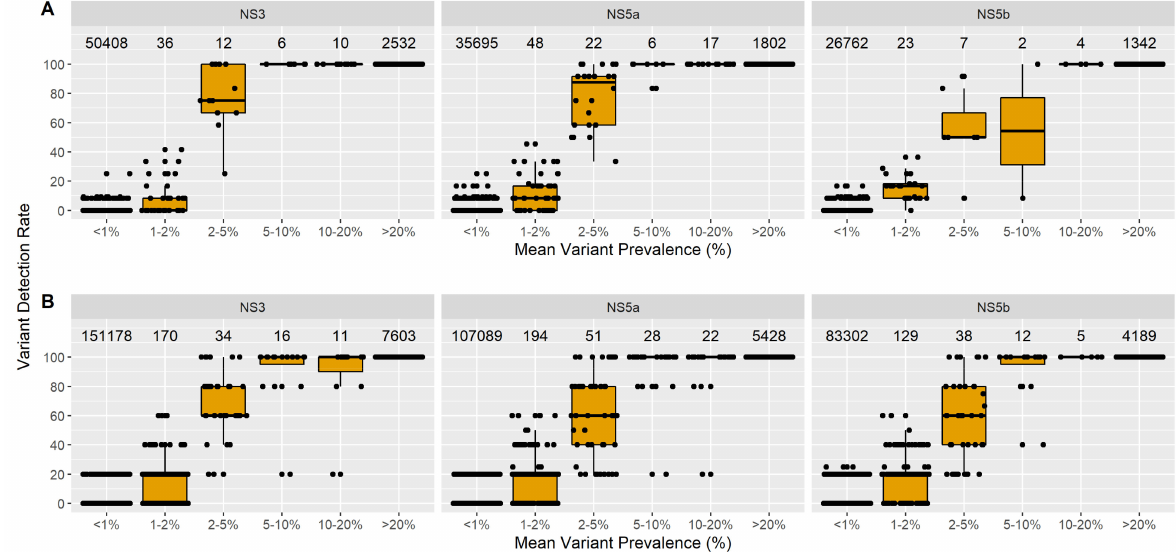
Figure 3. Repeatability and reproducibility of amino acid substitutions in NS3, NS5a and NS5b. Substitutions observed at a prevalence ≥ 2% in a given replicate were considered “detected”. Variant detection rate (defined as the % of replicates per sample, in which a substitution was detected) is categorized by the mean prevalence of a substitution across all replicates of a sample. Replicate testing of each sample began from the same RNA extract; all steps beginning from the RT-PCR were repeated. Numbers indicated on the top of each graph represent the total number of substitutions in each bin. ( A ) Repeatability of amino acid substitutions was determined using four samples (3 GT1a, 1 GT1b) in 12 replicates processed on a single MiSeq run. ( B ) The reproducibility of amino acid substitutions was determined using 12 samples (10 GT1a, 1 GT1b, 1 GT3) in 5 replicates processed on separate days on five separate MiSeq